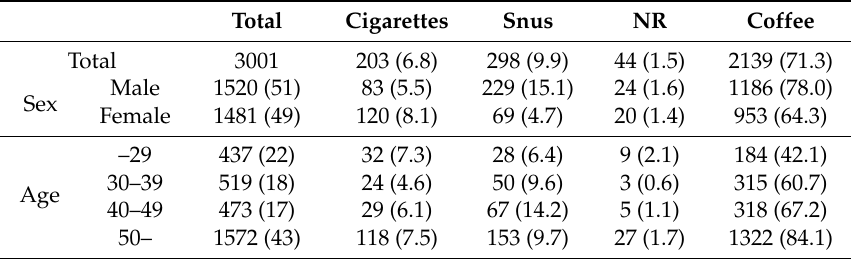
Table 1. Total number and number of daily users of cigarettes, snus, nicotine replacement (NR) and coffee. Values in parentheses are percentages within each sex/age group.